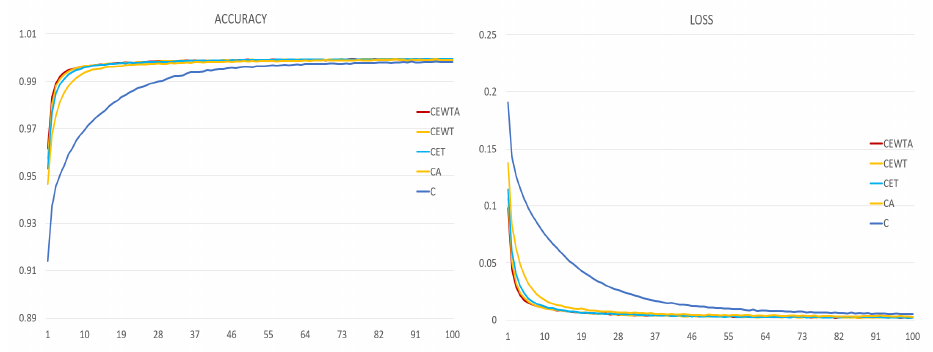
Figure 14. Performance of the five trained models, evaluated with accuracy ( left ) and loss ( right